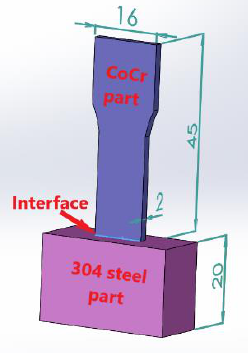
Figure 1. Virtual model of CoCr – 304 specimen for mechanical testing. (unit: mm)